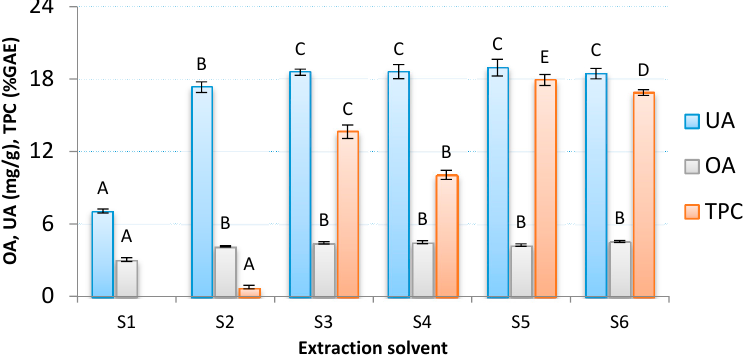
Figure 2. Content of OA, UA, and polyphenols (TPC) in the leaves of A. uva ursi as calculated per dry weight basis in extracts obtained with different solvents: S1, n -hexane (3 × 30 mL); S2, chloroform (3 × 30 mL); S3, chloroform-methanol 1:1 (3 × 30 mL); S4, chloroform (2 × 30 mL) + chloroform-methanol 1:1 (30 mL); S5, methanol (3 × 30 mL); and S6, n -butanol (3 × 30 mL). Values are presented as means ( n = 3) ± standard deviation (error bars). Different superscripts (capitals, A–E) for each analyte indicate significant differences in the means at p < 0.05.